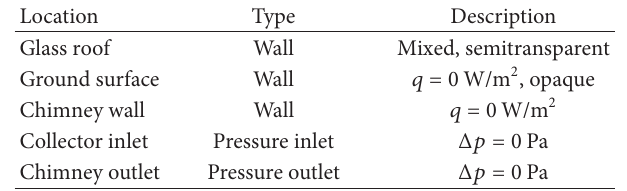
Table 2: Boundary condition assumptions for the SCPPs in